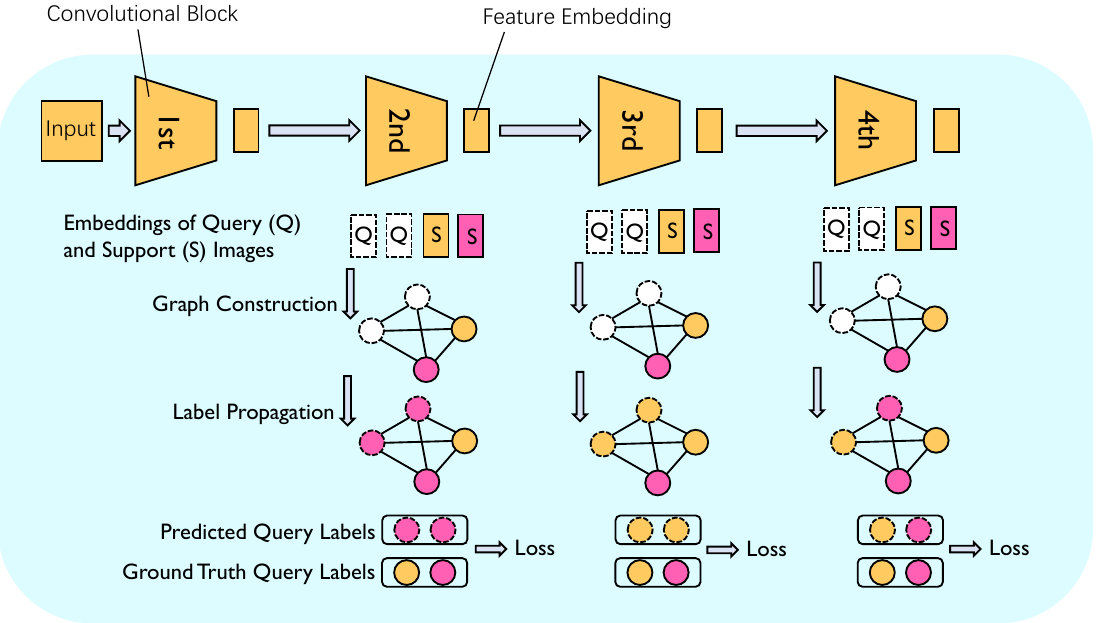
Figure 1. A conceptual overview of the proposed Looking-Back